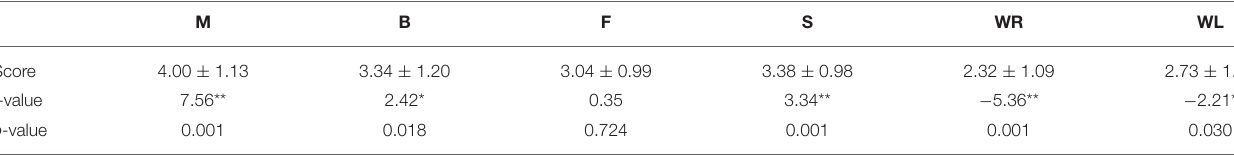
TABLE 2 | Comparison of the degree of preference of older adults with dementia on different types of sound sources. M